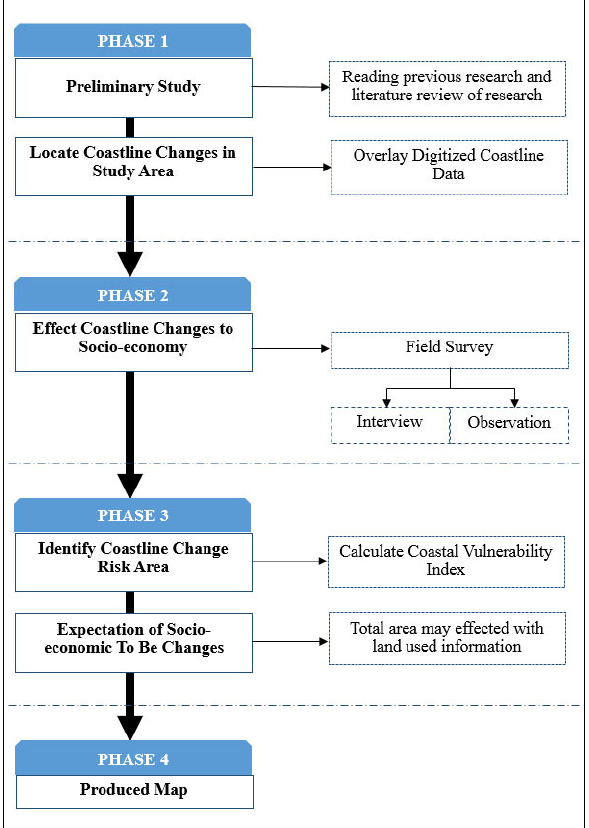
Figure 7. Research Work Flow of